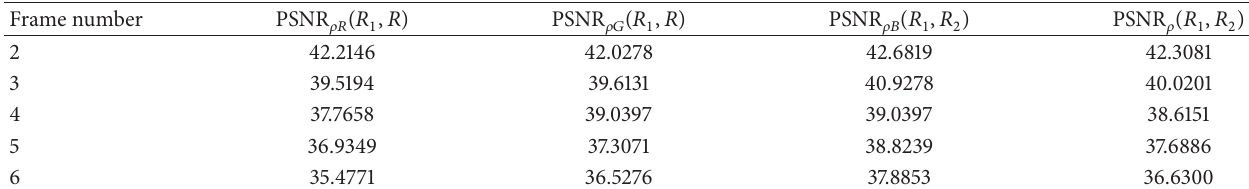
Table 5: PSNR with 𝜌 = 0.006944 for the Mom-Daughter video w.r.t. the first frame. Frame